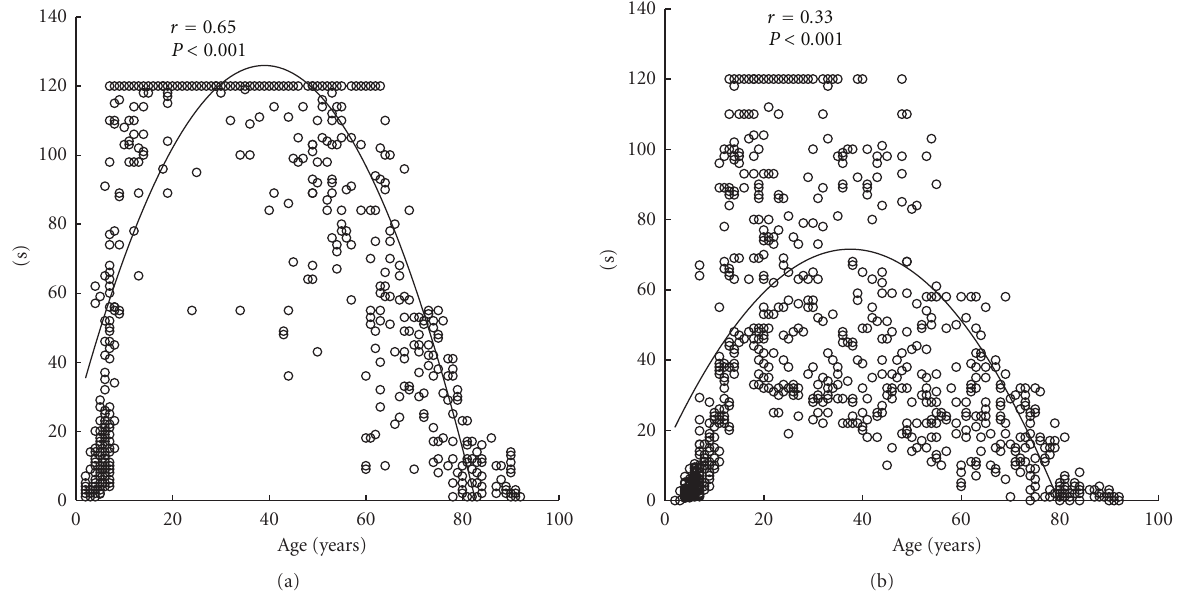
Figure 1: The standing time on one leg versus age for the eyes open (a) and eyes closed (b) along with the respective quadratic regression lines. All data is shown ( n = 1241). Ages at the maximum values in quadratic curves were 39.0 years for open eyes and 37.5 years for closed eyes.